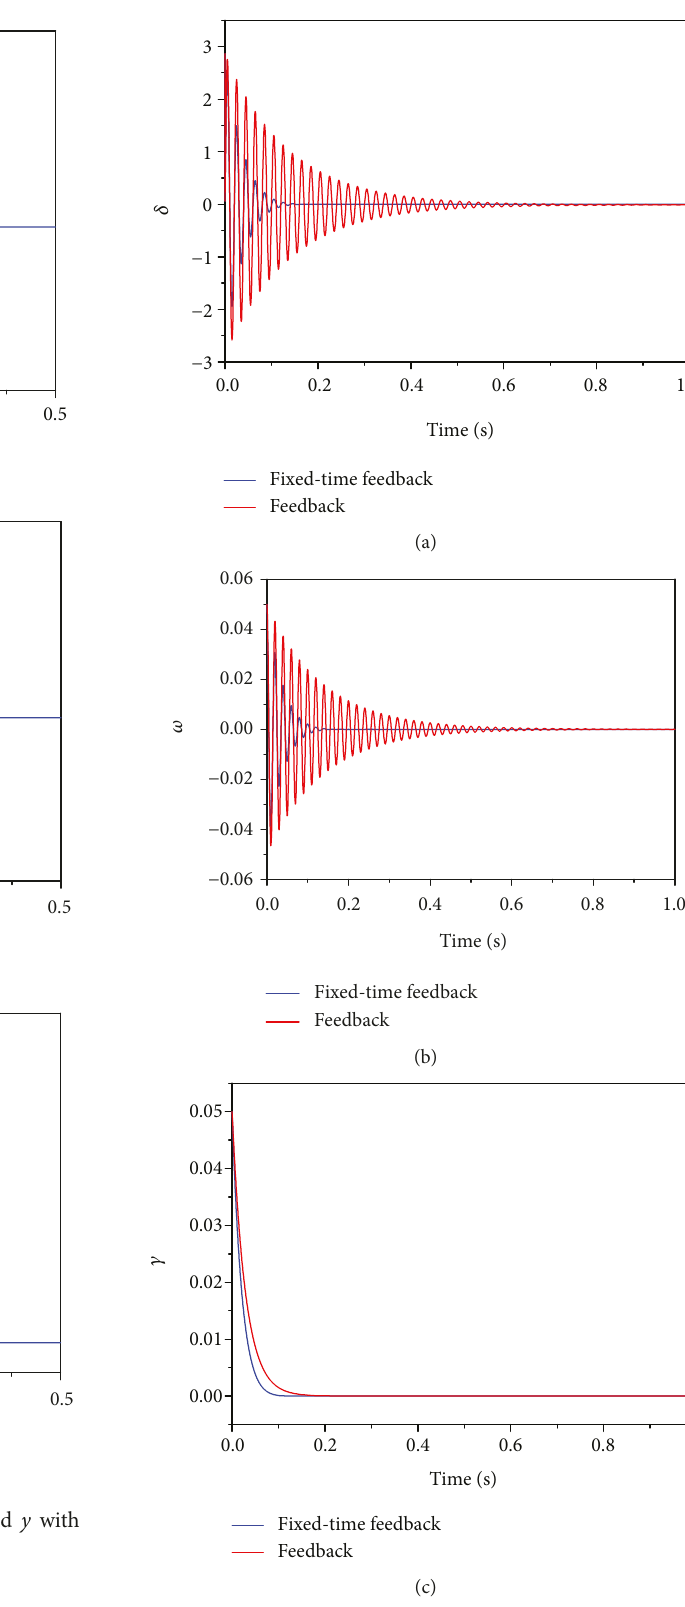
Figure 2: Comparison of converging speed of fi xed-time feedback and feedback